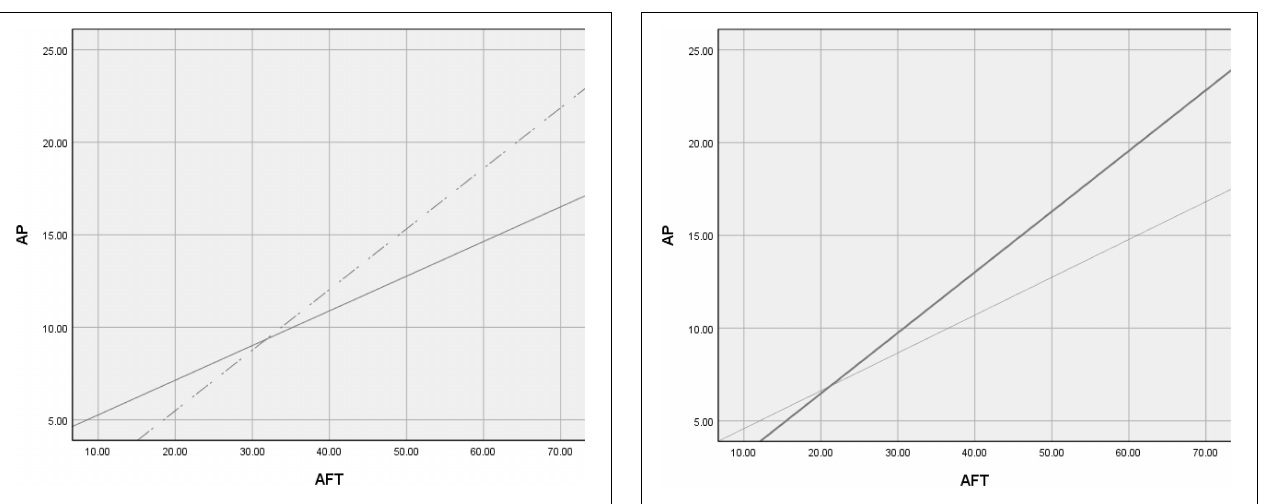
FIGURE 4 | Professional title as moderator. The dotted line represents participants high professional title ( R 2 = 0.0250), and the solid line represents participants low professional title ( R 2 = 0.0142).